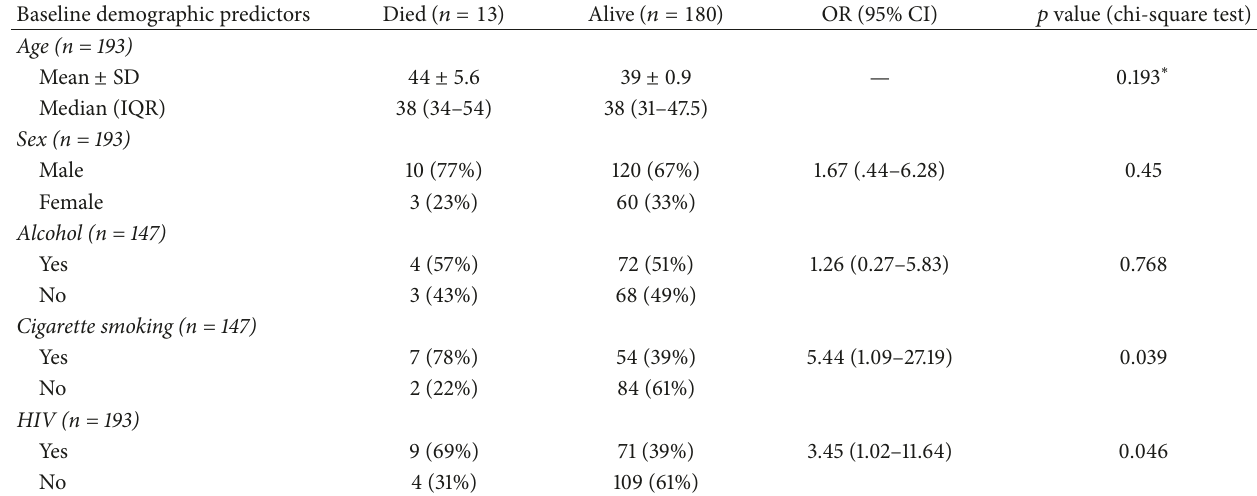
Table 2: Demographic data for predictors of MDRTB mortality.